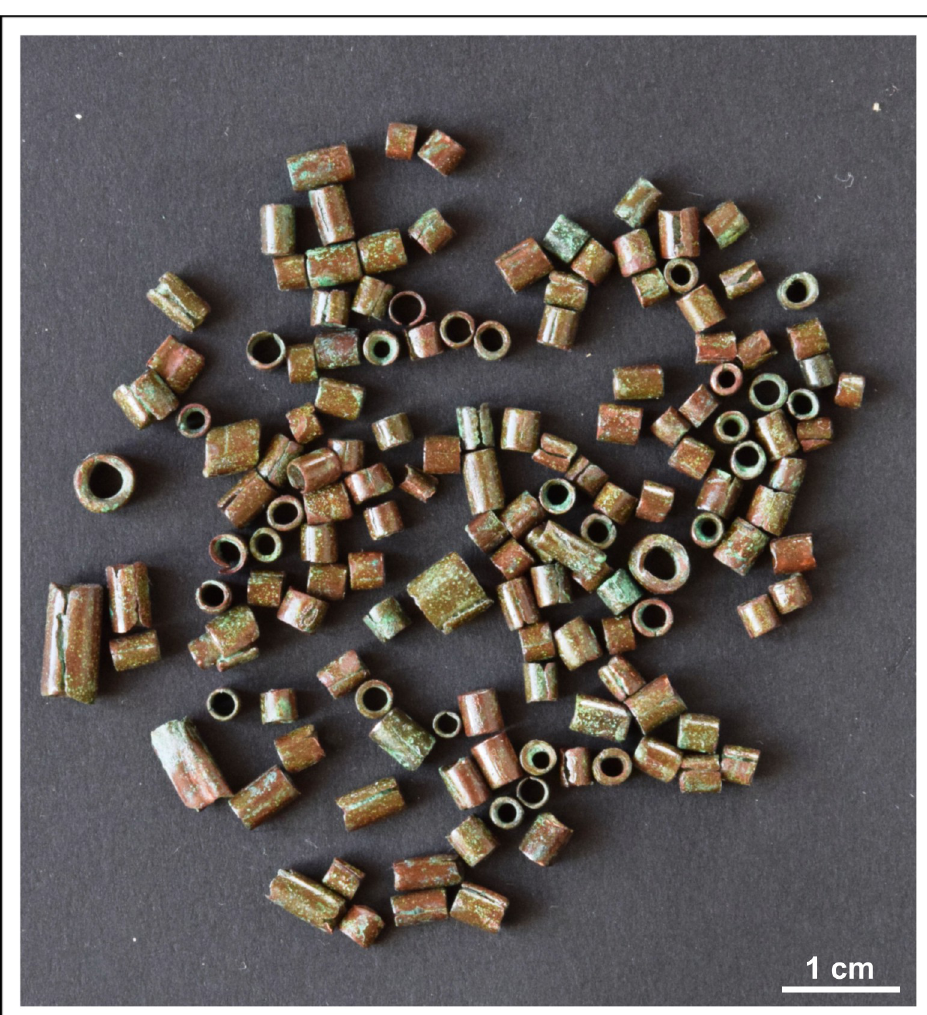
Fig 6. A selection of copper beads. Photo: Pe´ter